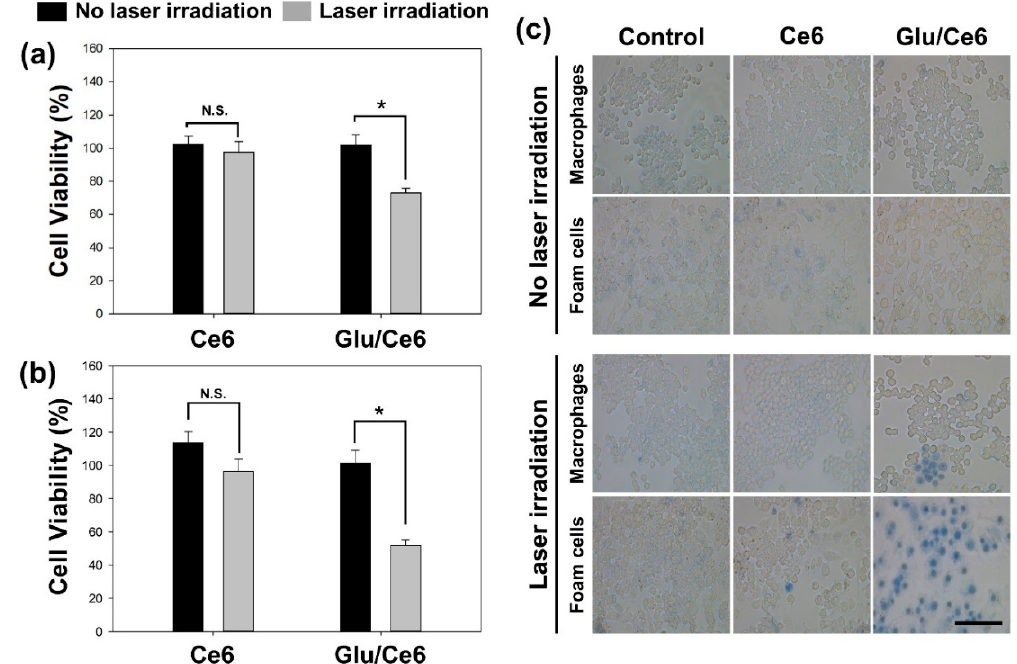
Figure 6. In vitro phototoxic effects of Ce6 and Glu/Ce6 on macrophages and foam cells. Comparison of in vitro phototoxic effects of Ce6 (2 µM) and Glu/Ce6 (equivalent 2 µM Ce6) on ( a ) macrophages and ( b ) foam cells before and after laser irradiation (670 nm, 1 min irradiation at 50 mW/cm 2 ). N.S.: Not Significant. * p < 0.05. ( c ) Trypan blue staining of macrophages and foam cells treated with Ce6 (2 µM Ce6) and Glu/Ce6 (equivalent 2 µM Ce6) before and after laser irradiation. Scale bar: 100 µm.